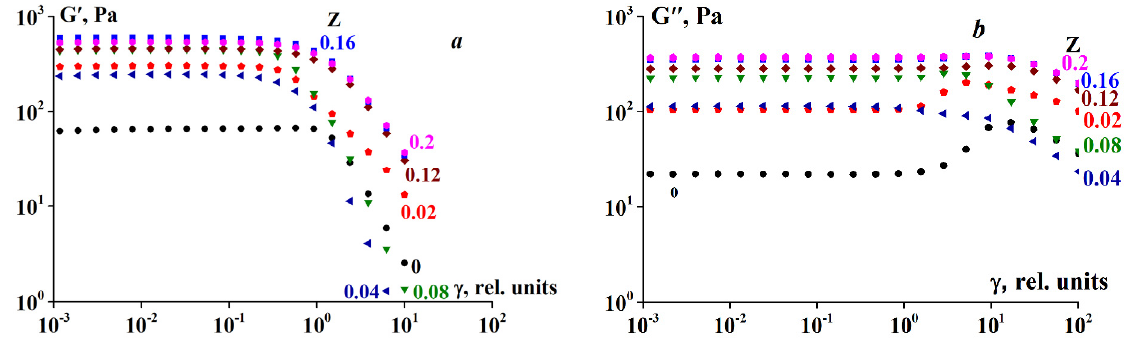
Figure 6. ( a ) Storage and ( b ) loss moduli dependency on amplitude at 4 ◦ C. ω = 6.28 rad/s. Gelatin concentration 10 wt.%. Z values are shown on the